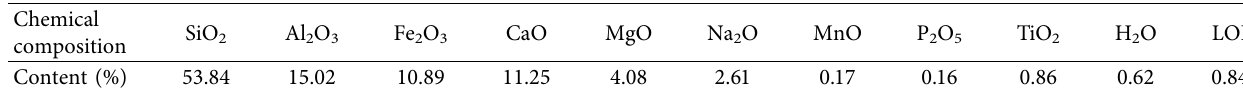
Table 4: Te chemical composition of scoria